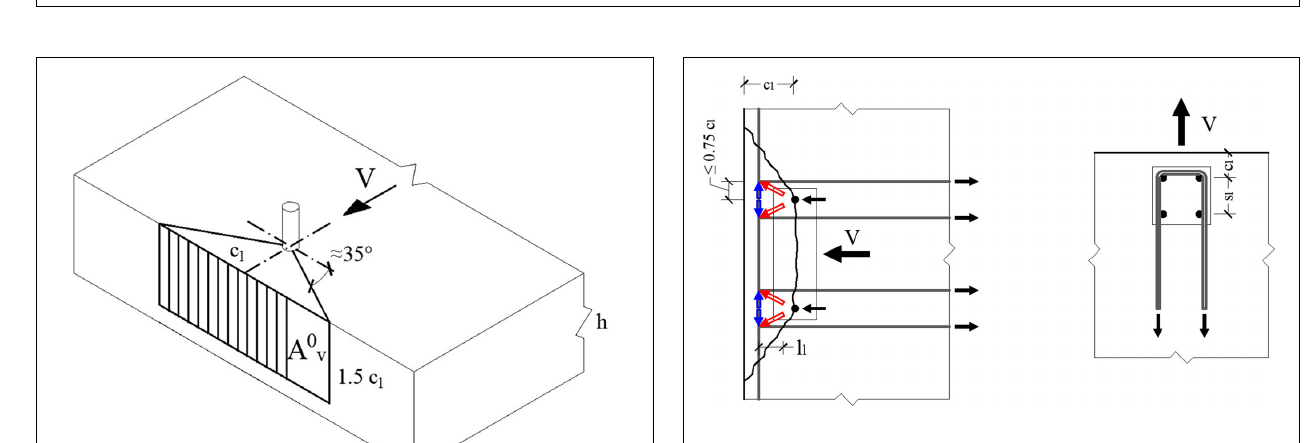
FIGURE 3 | Surface reinforcement to take up shear forces with simplified strut and tie model to design edge reinforcement. Adapted from EN 1992-4